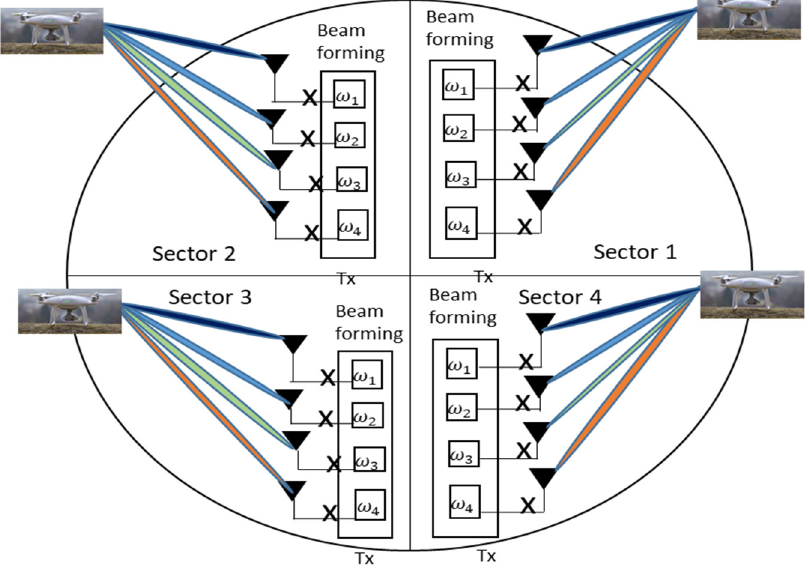
Figure 17. A four-sector beam-forming antenna for UAV tracking.